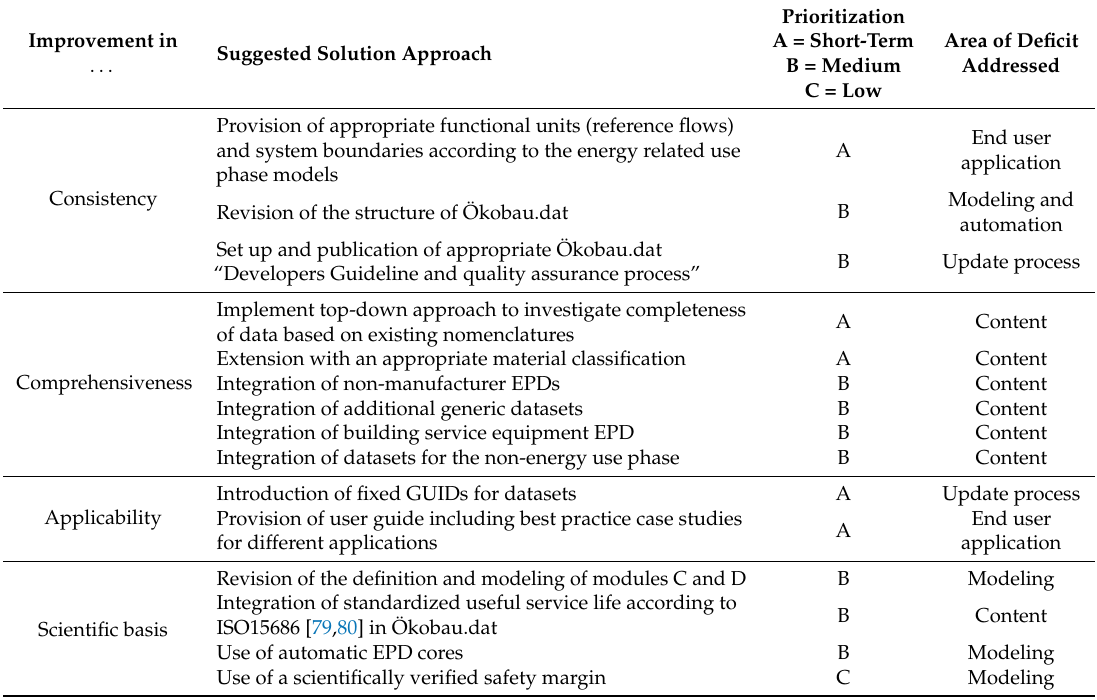
Table 6. Solution catalogue, implementation-oriented prioritization and mapping to area of